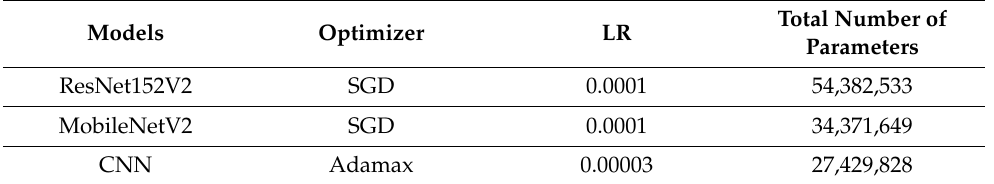
Table 6. Models training